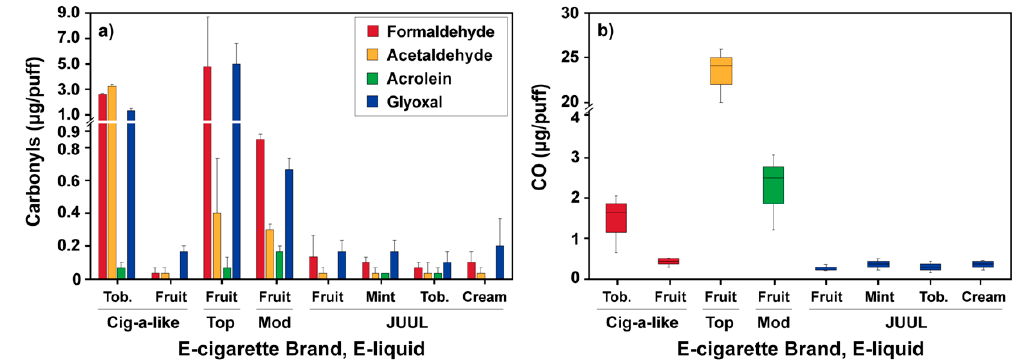
Figure 1. (a) Carbonyl and (b) CO concentrations for the combinations of the four different e-cigarette brands (cig-a-like, top-coil, ‘mod’, and JUUL) and flavored e-liquids (tobacco, fruit, mint, and cream flavored). The 50-watt power output was used for ‘mod’ device. Vaping topography was 100-mL puff volume, 4-sec puff duration, and 30-sec puff interval for all conditions (n = 3).